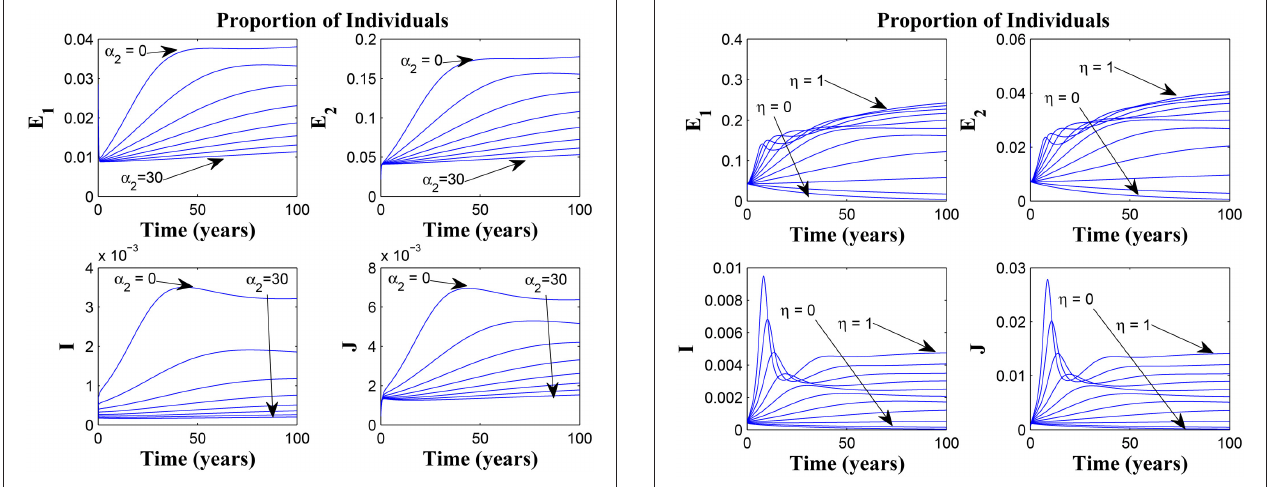
FIGURE 11 | Simulations of model (3) showing the number of infected individuals. Here, the disease transmission modification parameter ( η ) is